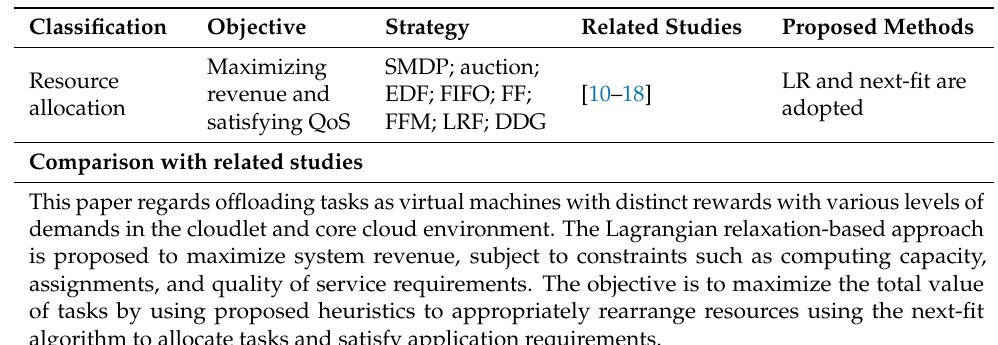
Table 1. Resource allocation comparisons with existing methods. SMDP, semi-Markov decision process; EDF, earliest deadline first; FF, First-fit; FFM, FF migration; LRF, least reliable first; DDG, decreased density greedy.